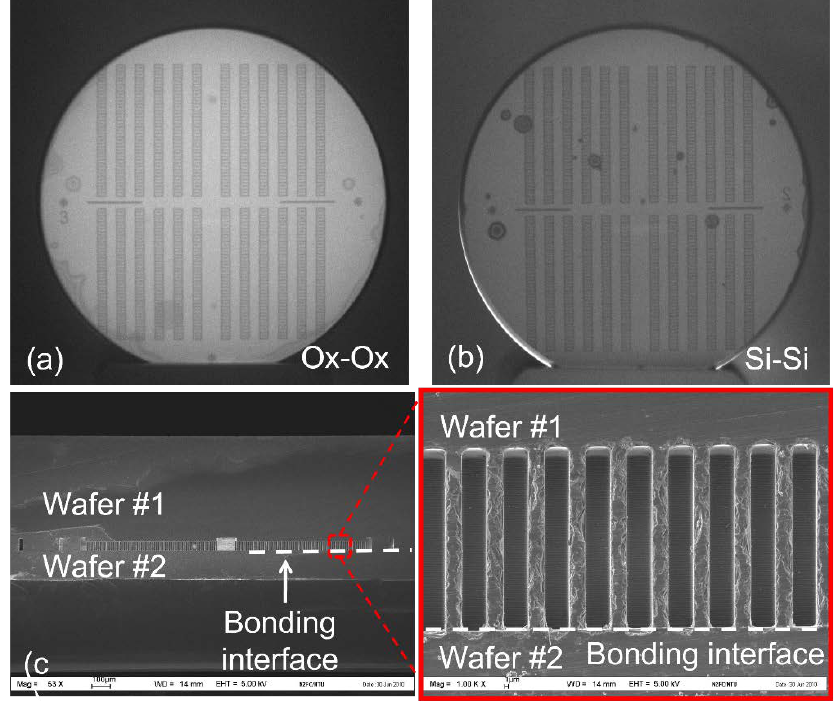
Figure 3. IR images for ( a ) oxide-to-oxide and ( b ) Si-to-Si wafer bonding using one blanket wafer and ( c ) one patterned wafer and cross-sectional SEM image for oxide–oxide wafer bonding.